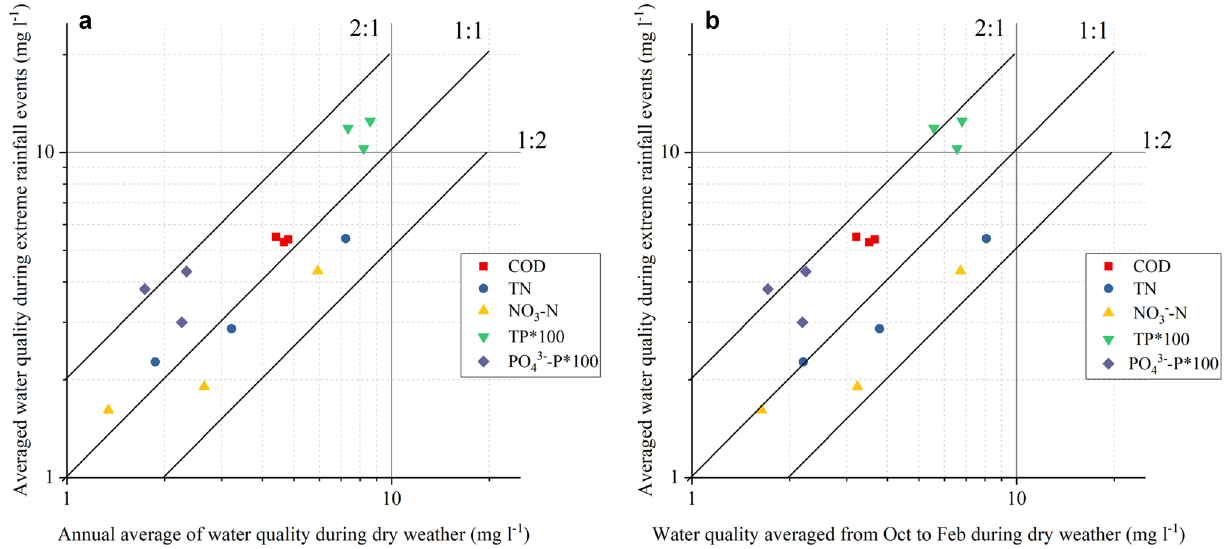
Fig. 3 Water quality comparison: monitoring at inflowing rivers during dry weather (baseflow condition) versus the lake water quality after extreme rainfall events (G1 of EREs). a Annual average at inflowing rivers. b Average of Oct to Feb